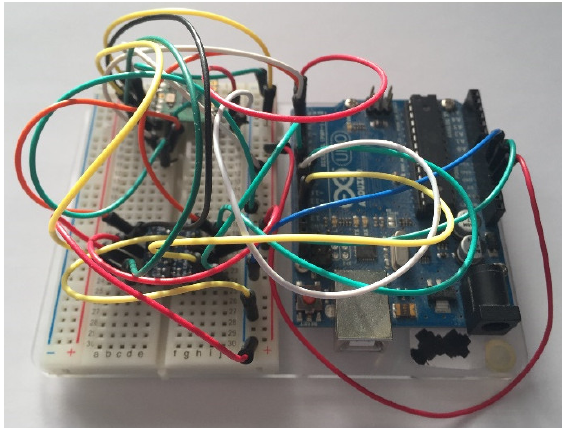
Figure 11. Photo showing the transmitter Arduino Uno.